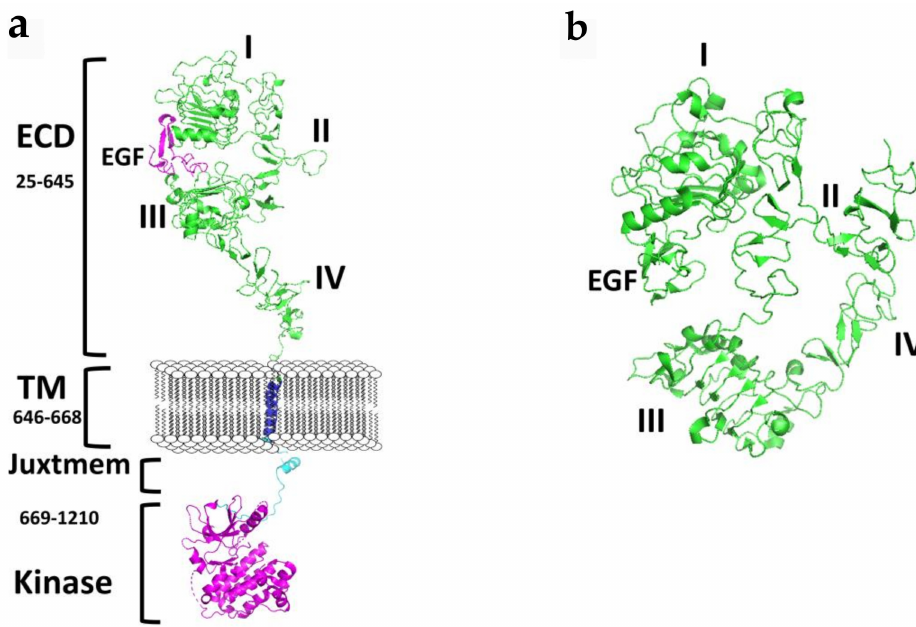
Figure 1. A schematic diagram of the structure EGFR. ( a ) Full-length EGFR showing extracellular domain (ECD) in an open conformation, transmembrane (TM), and the cytoplasmic kinase domain. Published crystal structures of EGFR were used to prepare the schematic. ECD (PDB ID: 3NJP); transmembrane (PDB ID:2KS1), Kinase domain with juxtamembrane domain (PDB ID: 3GOP). Notice the distance between domains II and IV in an open conformation. Dimerization arm II is open for dimerization interaction. ( b ) Structure of ECD of EGFR in the closed conformation (PDB ID: 1NQL). Domains IV is folded and interacts with II. In the closed conformation EGFR dimerization arm II is not available for dimerization. PyMol (Schrodinger LLC. OR) was used to generate the structures of EGFR. ECD, extracellular domain; eJM, extracellualr juxtamembrane; TMD, transmembrane domain; iJM, intracellular juxtamembrane; TKD, tyrosine kinase domain